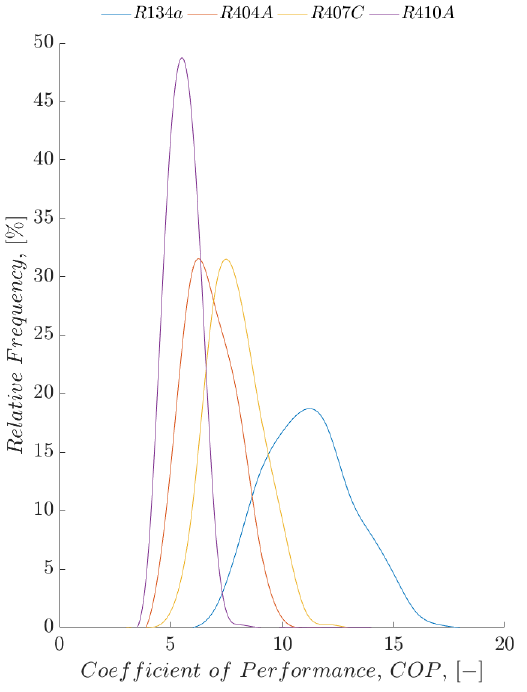
Figure 27. Relative frequency of the COP of the optimized system for all refrigerants.